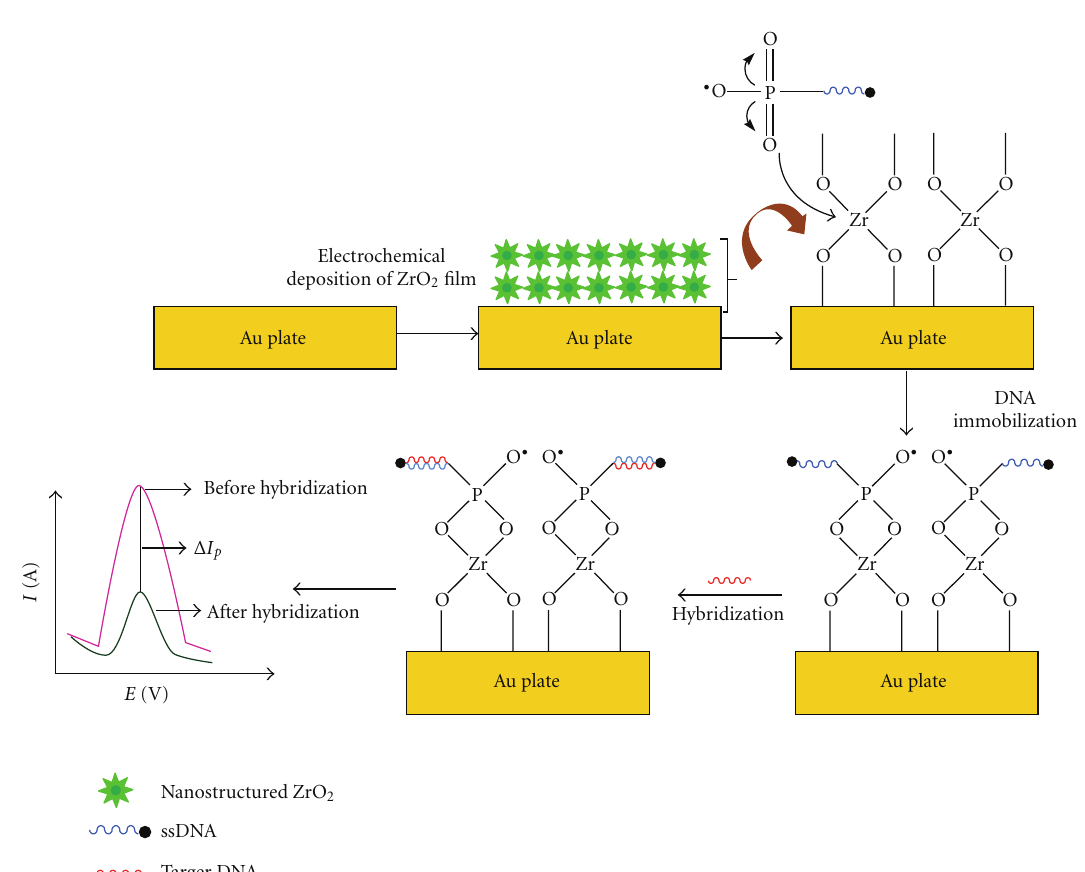
Figure 2: Proposed schematic for the fabrication of nano-ZrO 2 /Au-based DNA biosensor. Reprinted with permission from [63]. Copyright 2010, Applied Physics